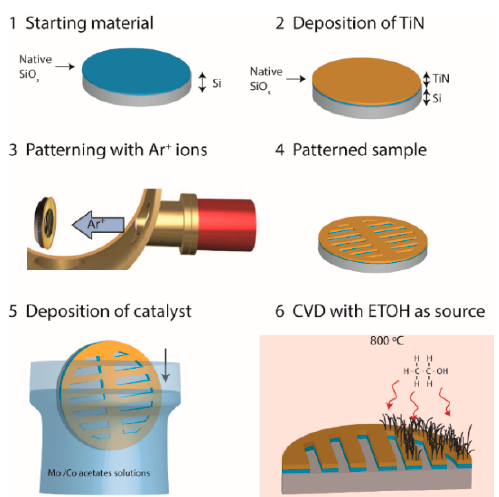
Figure 1. Scheme of the different steps ( 1 – 6 ) for the preparation process of the TiN/sputtered-Si substrates, and the subsequent growth of SWNTs.